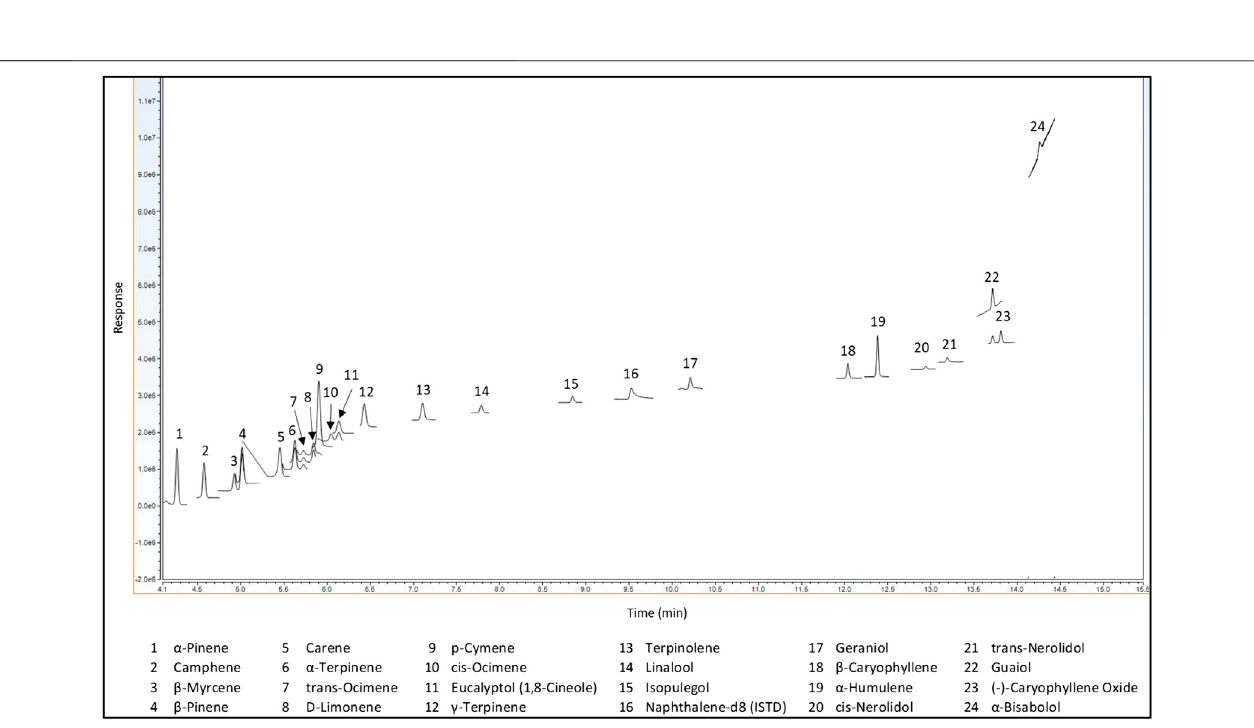
FIGURE 4 | Full separation of 23 terpenes with GC-MS (LI-Syringe).